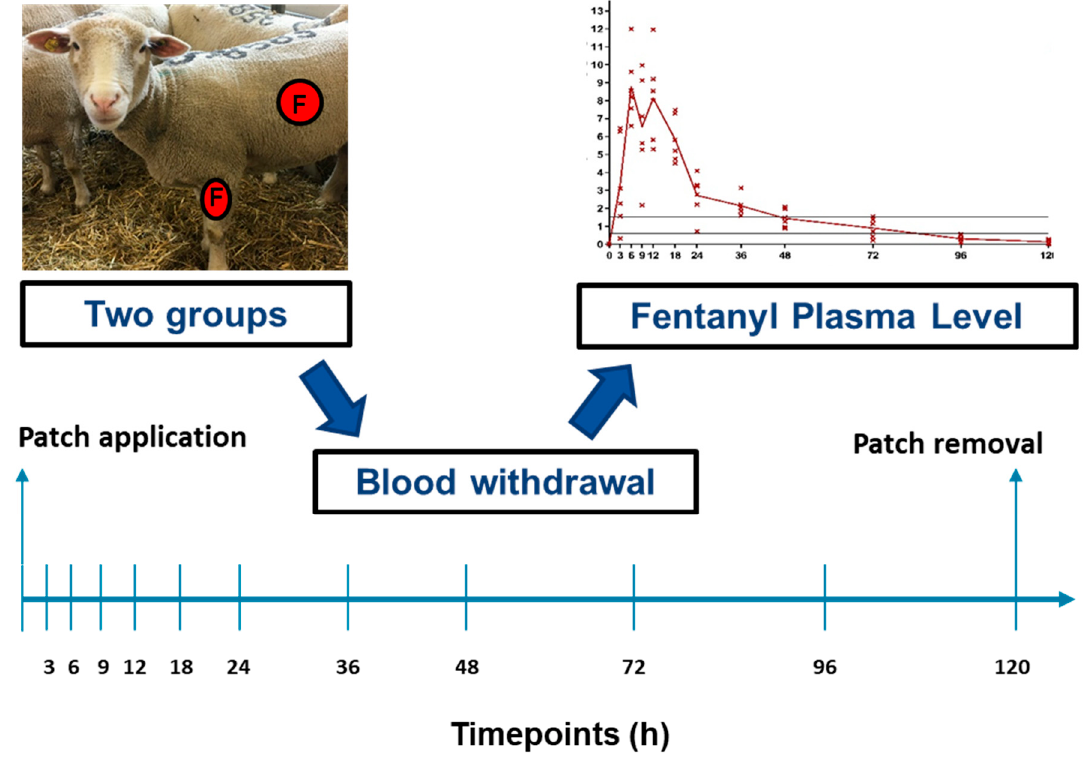
Figure 1. Study Design Overview—The letter “F” in the first picture shows the locations of the TFP on the sheep. However, only one location was used per sheep. After application of a transdermal fentanyl patch (TFP) to one of two possible locations depending on group allocation, fentanyl plasma levels were measured at different time points.